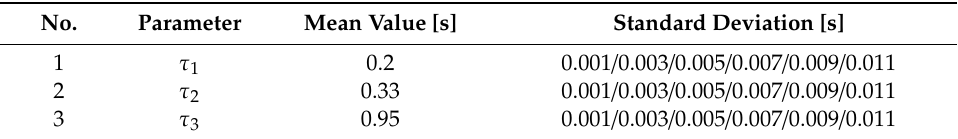
Table 3. Parameters for the Monte-Carlo simulation (igniters’